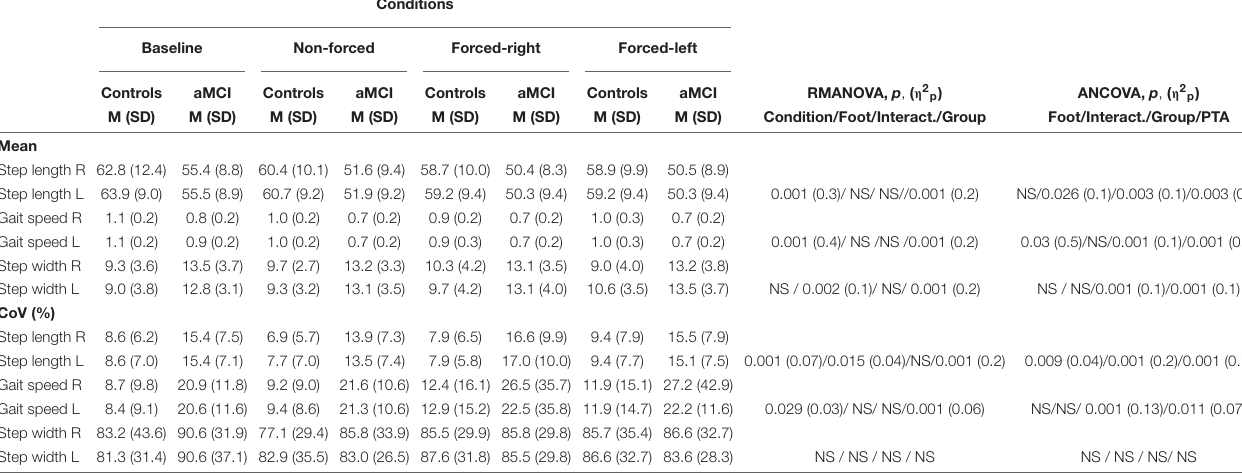
RMANOVA and ANCOVA with Bonferroni correction for multiple comparisons. Interactions marked with † refer to = Condition × Foot p < 0.05. Units for Step length, Step width and Stride length = cm.; units for Gait speed = m/s. M, mean; SD, standard deviation; R, Right; L, Left; RMANOVA, repeated measures analysis of variance; ANCOVA, Analysis of covariance; CoV, Coefficient of Variation; Interact., Interactions; PTA, Best Pure Tone Audiometry values; NS, non-significant; CoV, calculated with the formula: (SD/mean) × 100.